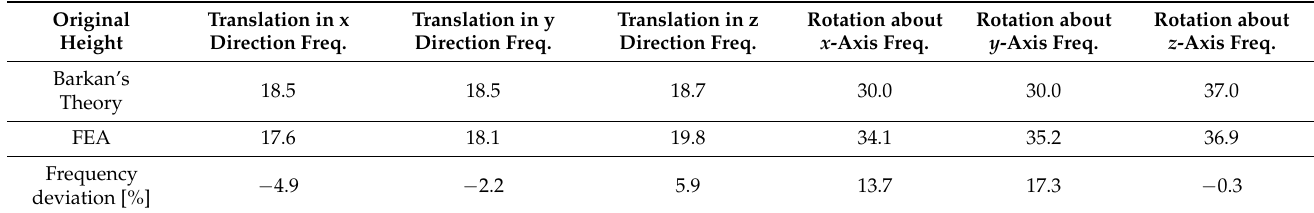
Table 2. Comparison between Barkan’s theory and FEM results.